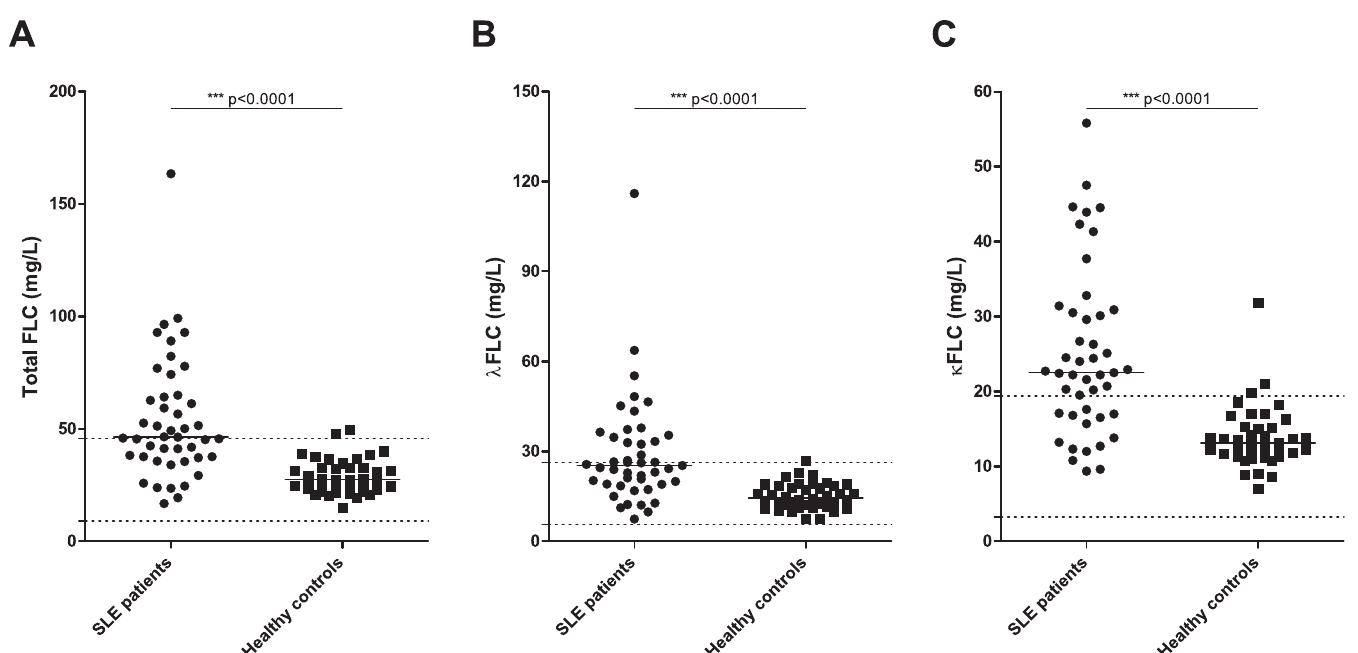
Fig 1. Concentration of serum FLCs in SLE patients and healthy controls. Total FLC (A), λ FLC (B) and κ FLC (C) levels in SLE patients (n = 45) and healthy controls (n = 40) measured by quantitative nephelometry. SLE patients suffering from renal insufficiency (eGFR < 60 ml/min/1.73m 2 ) were excluded. Middle horizontal bars represent median and statistical significant differences are indicated with * , ** or *** for p-values less than 0.05, 0.01 or 0.001. p- values for comparison of FLC levels in SLE patients and healthy controls are < 0.0001. Maximum and minimum values of the normal ranges of λ FLCs and κ FLCs are indicated on the y-axis as dotted lines. FLCs — free light chains, SLE — systemic lupus erythematosus.